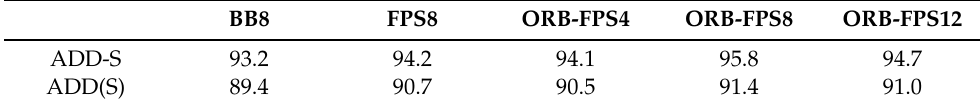
Table 3. Experiment results on YCB dataset of the different keypoint selection approaches. BB8 FPS8 ORB-FPS4 ORB-FPS8 ORB-FPS12 ADD-S 93.2 94.2 94.1 ADD(S)